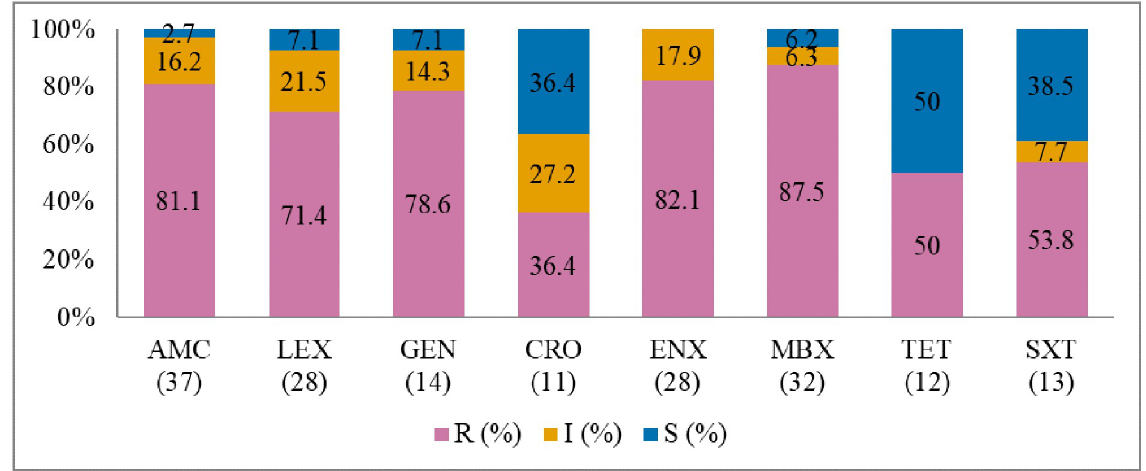
Fig 5. Antibiotic susceptibility pattern from Klebsiella pneumoniae isolates from diseased cats (January 2015–December 2017). R– resistance; I-intermediate; S–susceptible; AMC–amoxicillin/clavulanic acid; LEX–cephalexin; GEN–gentamicin; CRO–ceftriaxone; ENX– enrofloxacin; MBX–marbofloxacin; TET–tetracycline; SXT–trimethoprim-sulfamethoxazole. Numbers inside brackets ‘()’ indicate the total number of tested isolates for each antibiotic.